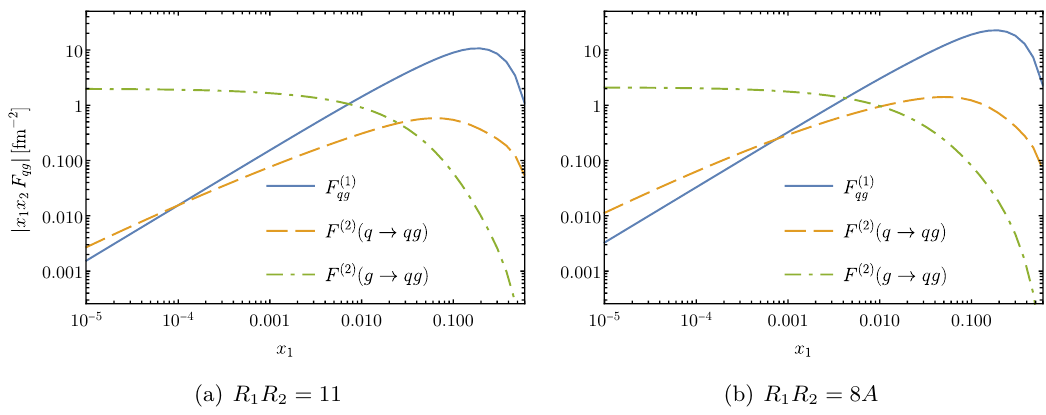
Figure 16 . Absolute values of the different contributions to R 1 R 2 F ug at x 2 = 0 . 1 , evaluated at central scales with the CT14 PDFs. The case R = 8 S is not shown here, because according 1 R 2 to (4.4) and 4.25 one has 8 S F = − p 5 / 9 8 A F for each separate ug ug